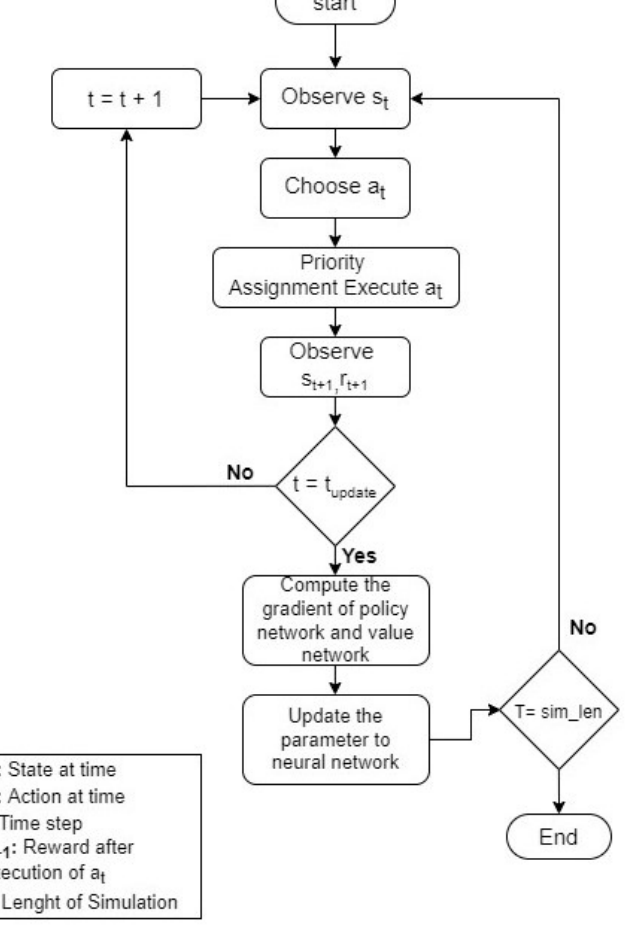
Figure 6. Flow of Intersection Control